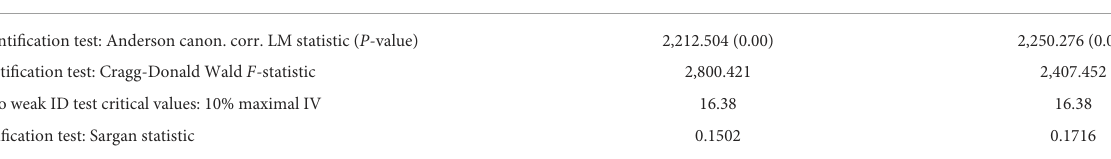
TABLE A1 Validity test of the instrumental